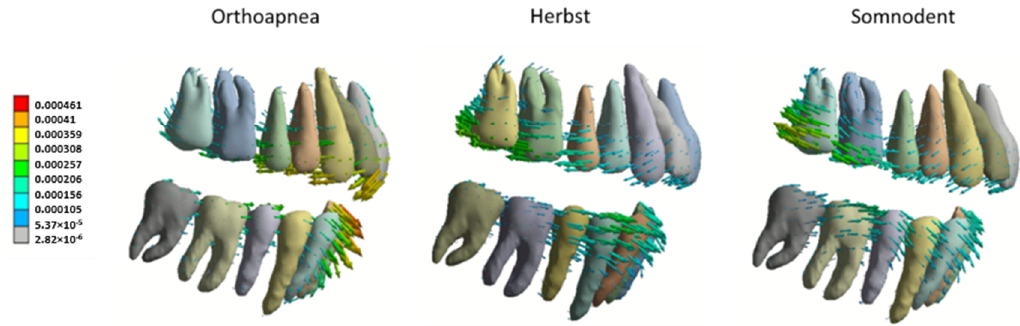
Figure 5. Deformation (mm) on teeth from a lateral view. Arrows indicate the direction of tooth displacement and its intensity (red for higher displacement; blue and grey for lower displacement).